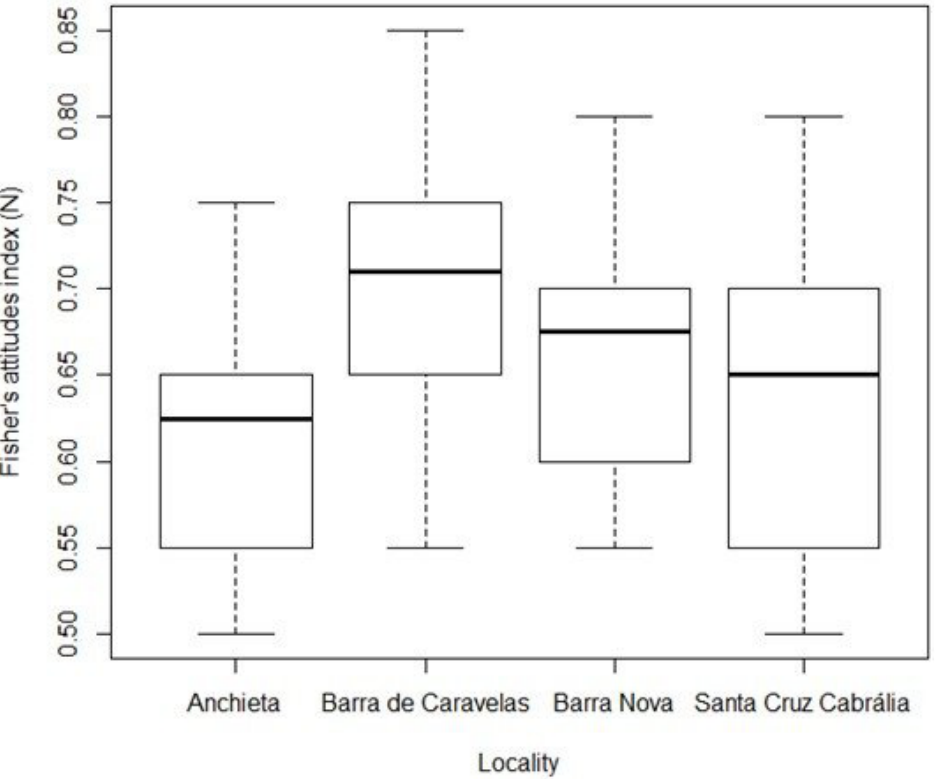
Figure 2. Box plot of the conservationist attitudes of fishers among the studied